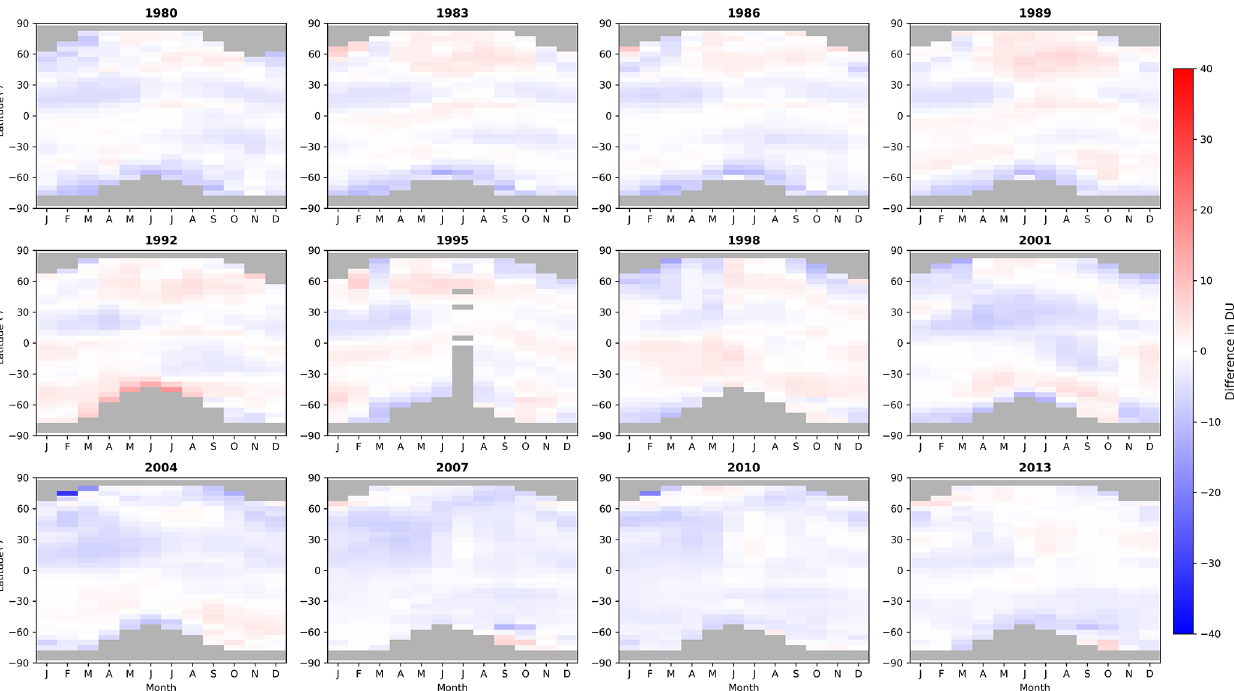
Figure 9. Differences between monthly mean zonal means calculated from the NIWA-BS TCO database and the NASA SBUV V8.6 database (NIWA-BS minus SBUV) for 12 selected